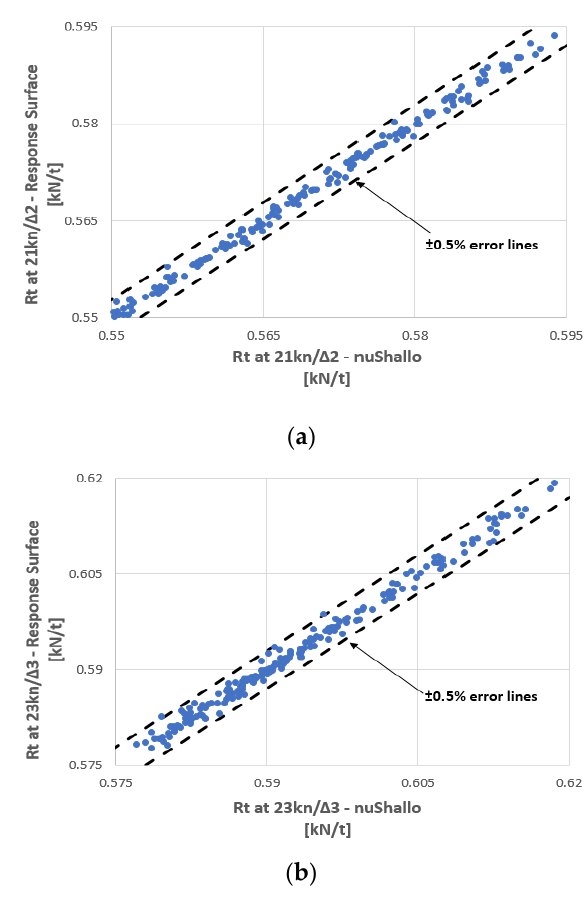
Figure 5. Comparison of calm water resistance per ton of displacement obtained with the response surfaces and v-SHALLO for ( a ) speed 21 kn at displacement Δ2 and ( b ) speed 23 kn at displacement Δ3.